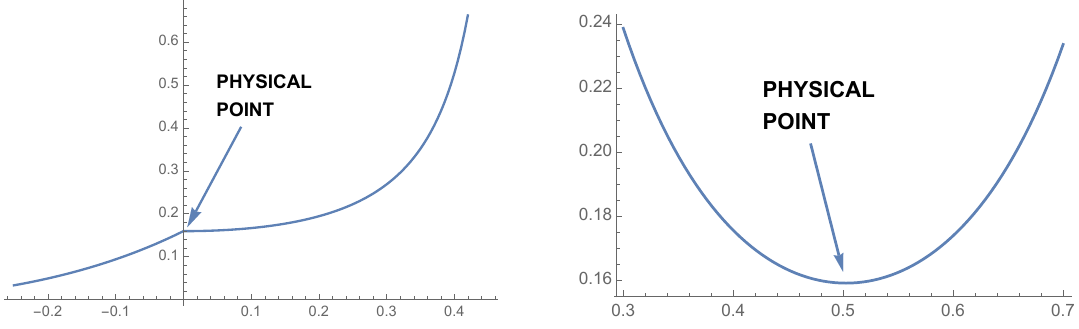
[0 ; r q ; 0]. The qualitative behavior for SU(2)